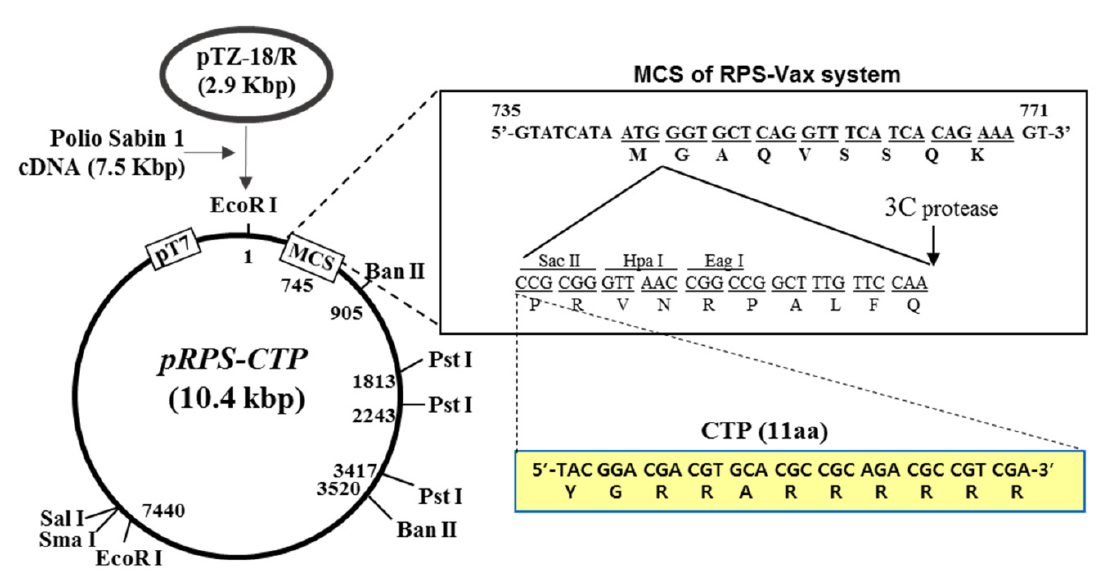
Figure 3. RPS-vector system as a potential platform for COVID-19 oral mucosal vaccine (Seung-Soo et al., 2015).